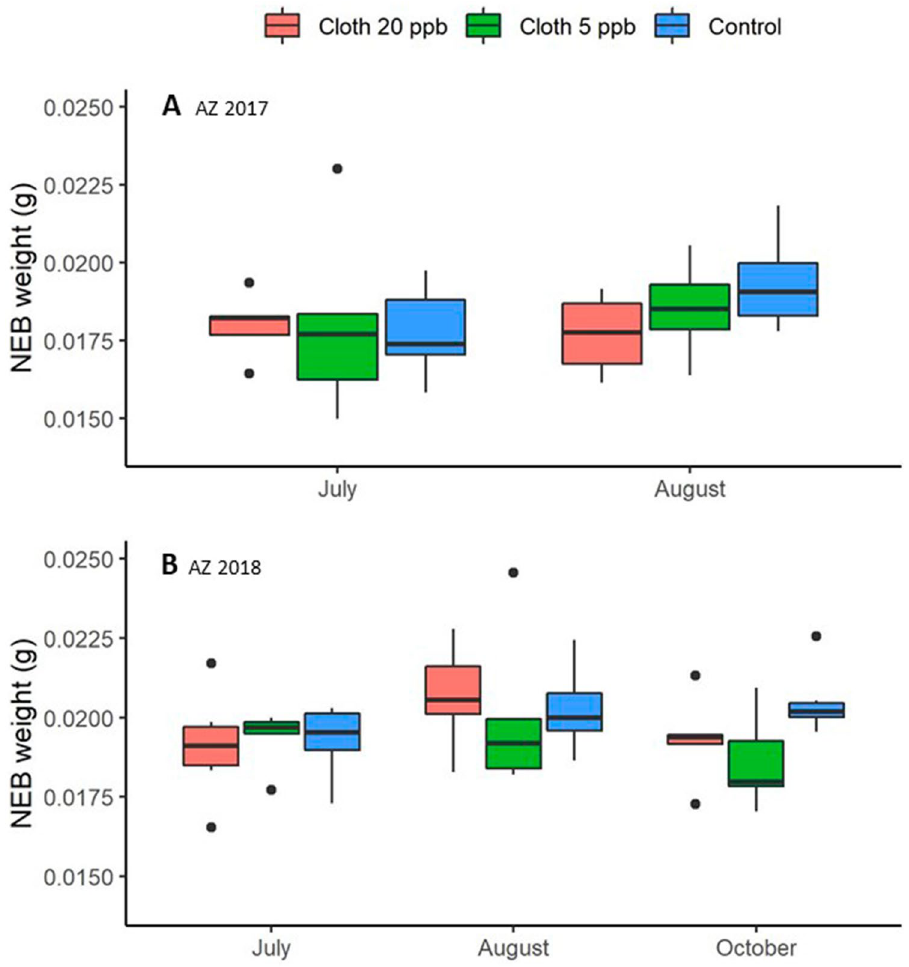
Figure 4. Average Newly Emerged Bee (NEB) dry weights for each of 3 treatment groups: Clothianidin 20-ppb (orange), clothianidin 5-ppb (green), control (blue). ( A ) AZ 2017 (2 sampling dates); ( B ) AZ 2018 (3 sampling dates). Boxes are defined as 1.58 * IQR/n 0.5 , where IQR is the inter-quartile range and n is the number of data